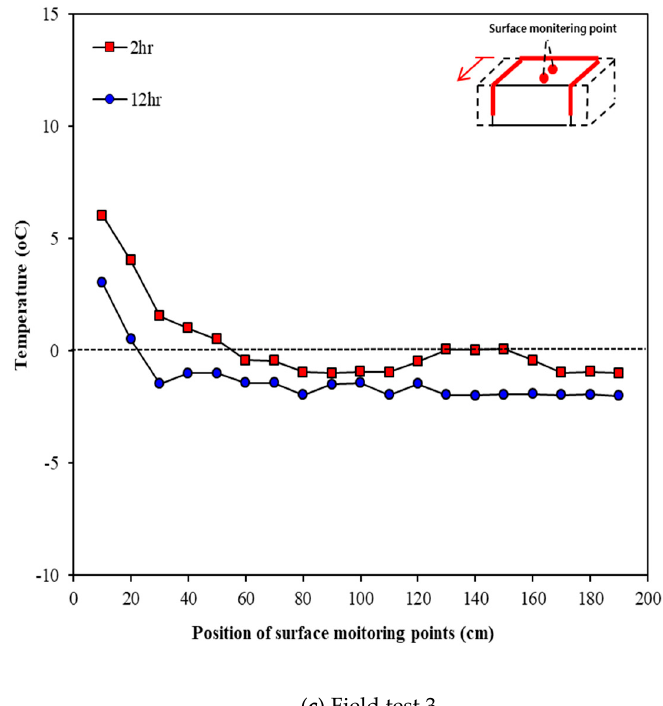
Figure 17. Variations in temperatures at different surface locations with time (Line 3). Materials 2020 , 13 , 2504